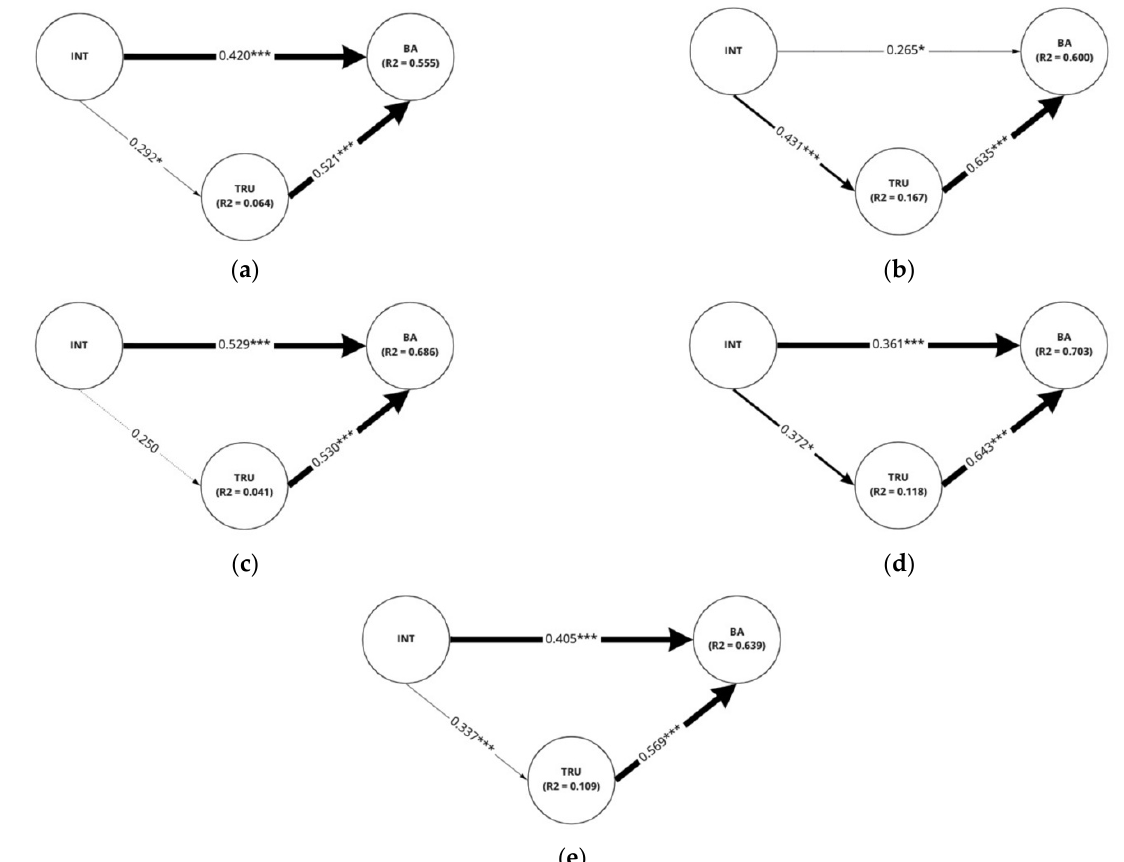
Figure 9. Public shuttle scenario: results of analysis on each structural model for the application of eye movement and conversational distance ( a ) eye movement applied and conversational distance close; ( b ) eye movement unapplied and conversational distance far; ( c ) eye movement unapplied and conversational distance close; ( d ) eye movement applied and conversational distance far; ( e ) full sample for the scenario. INT: Intimacy, TRU: Trust, BA: Brand Attitude INT: Intimacy, TRU: Trust, BA: Brand Attitude. * R 2 values indicated in the figures are adjusted values of R 2 . * p < 0.05, *** p < 0.001.